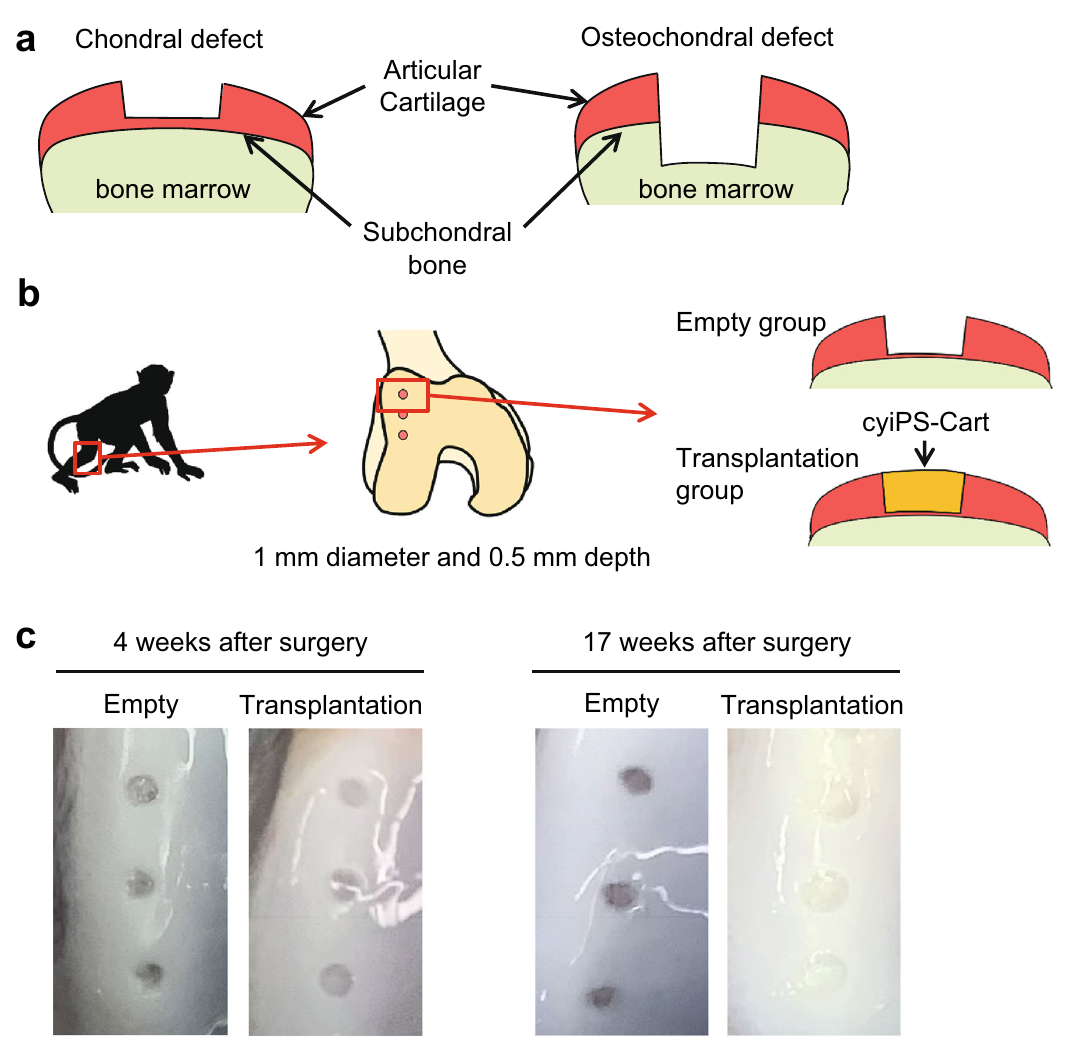
Fig. 1 | Transplantation of cyiPS-Cart in the knee joints in a primate model. a Two categories of articular cartilage defect. Left: chondral defects extending down to but not through the subchondral bone. Right: osteochondral defects extending down through the subchondral bone. b Primate model for cyiPS-Cart transplantation.Chondraldefectswerecreatedinthefemoraltrochlearridgeofthe